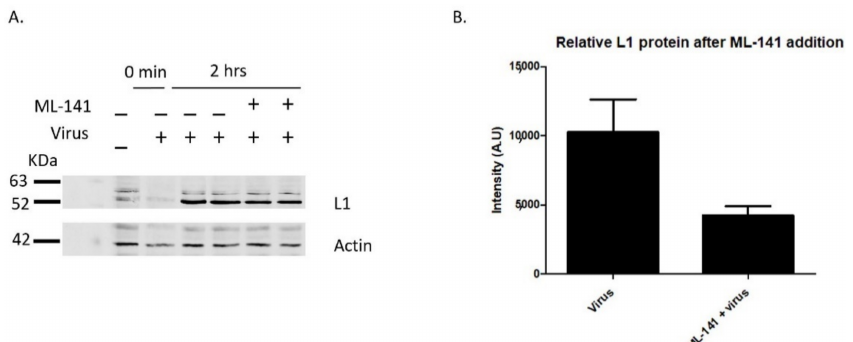
Figure 5. ML-141 treatment reduces viral binding. L1 viral capsid protein was measured via western blot after the incubation of 10 µ M ML-141. HaCaT cells were treated with ML-141 for 2 h prior to viral addition at 37 ◦ C. PsVs were added for 0 min or 2 h with samples incubated with or without the drug on ice. HaCaT cells were washed three times with 1 × PBS and then harvested with trypsin. ( A , 1st lane) control sample without PsVs and drug, ( A , 2nd lane) control sample with virus that was immediately washed off, ( A , 3rd and 4th lane) control infection after 2 h, ( A , 5th and 6th lane) cells treated with ML-141 and virus for 2 h. ( B ) Densitometry data of western blot in A showing the relative intensity of L1 protein normalized to actin for two samples from different wells treated with either virus or virus and 10 µ M ML-141.